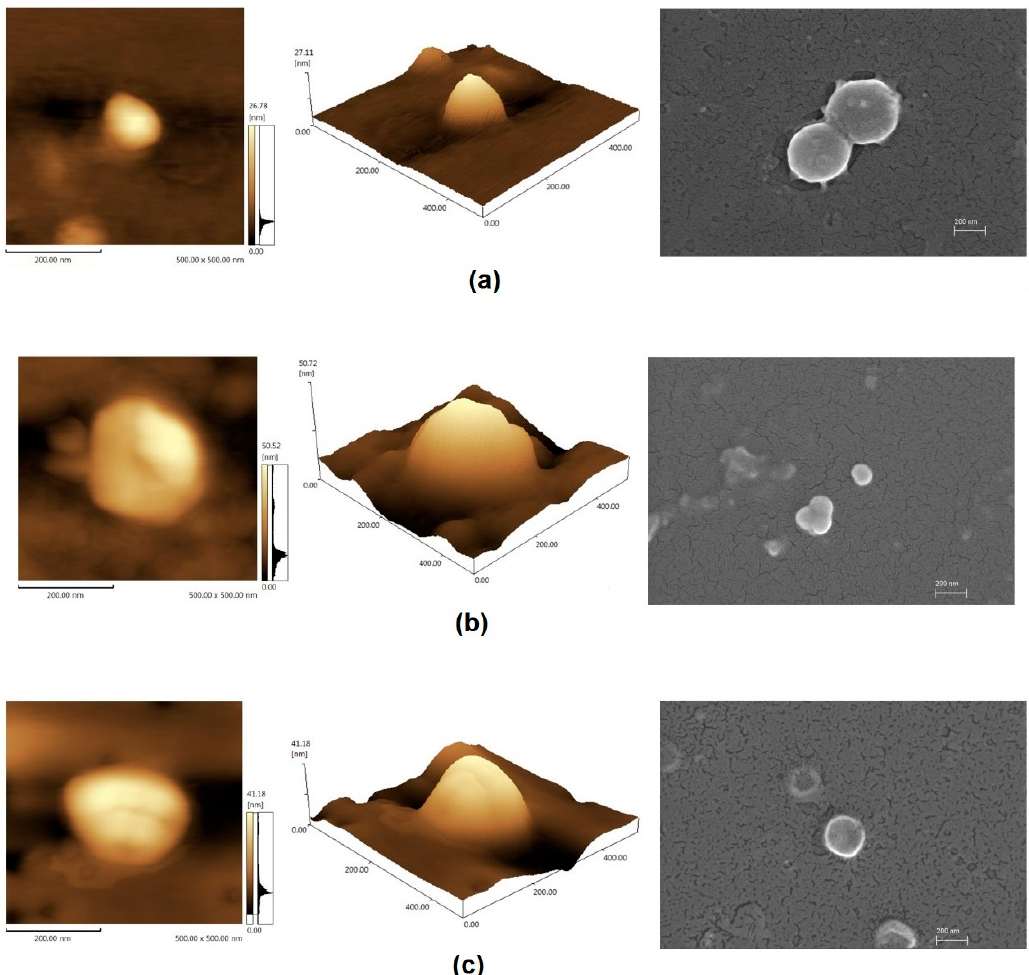
Figure 1. Morphology analyses of 2D and 3D atomic force microscopy (AFM) images and SEM images, respectively, of ( a ) blank-solid lipid nanoparticles (SLN-B), and phytol-loaded solid lipid nanoparticles (SLN-PHY) ( b ) 5-SLN-PHY and ( c ) 3-SLN-PHY.